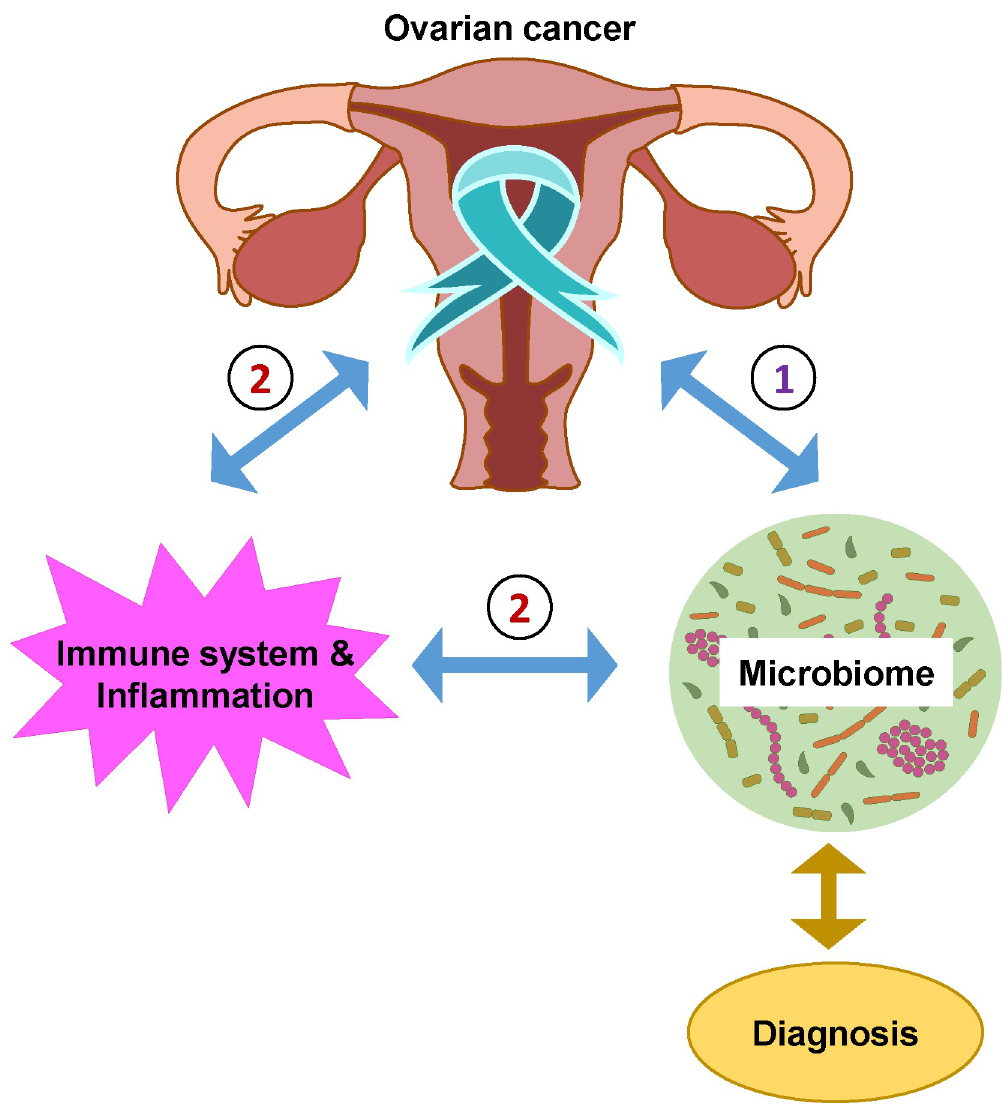
malignant cells or 2) through the alteration of the patient’s immune system/inflammatory status. We hypothesize that changes in microbial profiles associated with the presence of ovarian cancer may be characterized and used as diagnostic